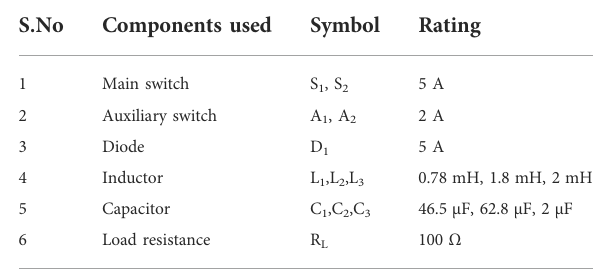
TABLE 1 Components used in the proposed converter.